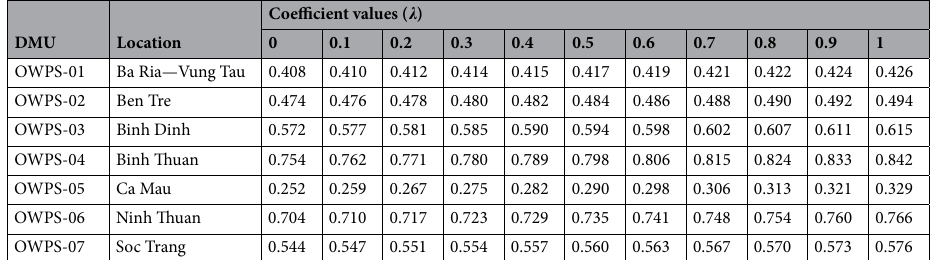
Table 14. The fluctuation threshold value of the WASPAS model.